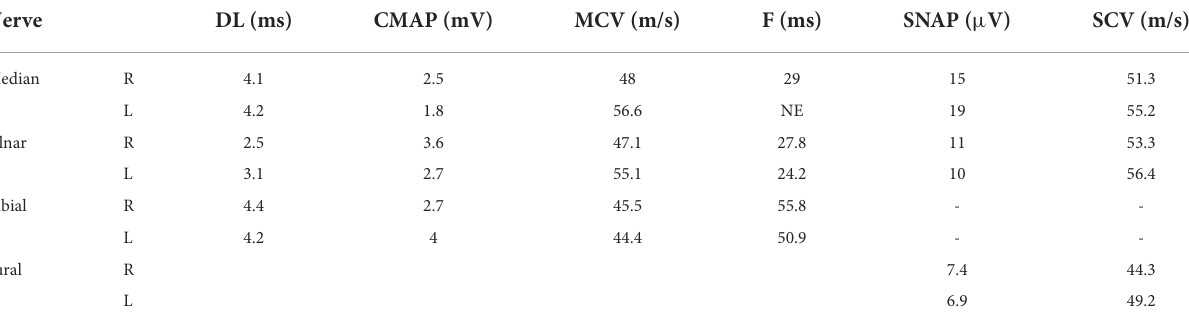
TABLE 1 Results of nerve conduction